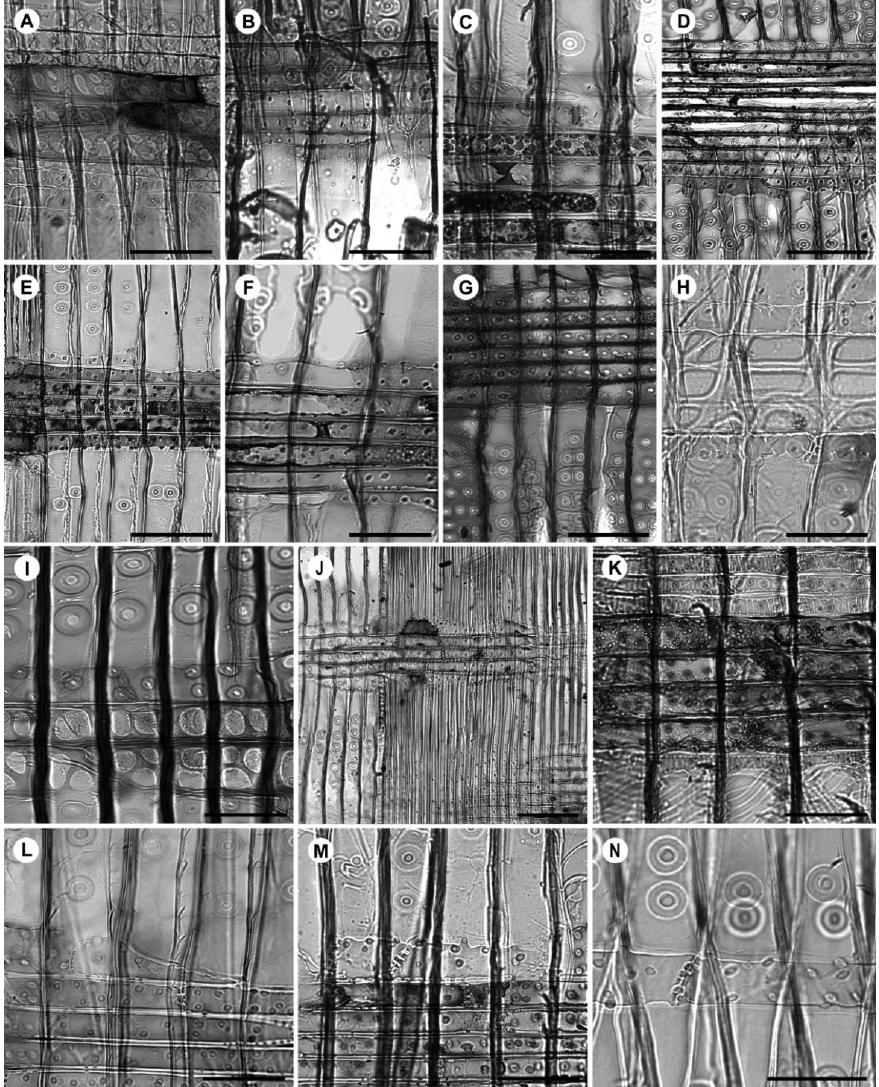
Figure 2. Rays. ( A – I ) Ray tracheids. ( A ) Pinus echinata . ( B ) Picea alcoquiana . ( C ) Larix occidentalis . ( D ) Cedrus atlantica . ( E ) Nothotsuga longibracteata . ( F ) Tsuga diversifolia . ( G ) Ray tracheids absent Keteleeria davidiana . ( H ) Dentate ray tracheids Pinus resinosa . ( I ) Smooth ray tracheids Pinus wallichiana var. wallichiana . ( J ) Irregularly shaped marginal ray cells Cedrus libani . ( K ) Helical thickenings in ray tra- cheids Pseudotsuga sinensis . ( L – N ) Ray parenchyma. ( L ) Pitted horizontal walls Abies nephrolepis . ( M ) Nodular end walls Abies nordmanniana subsp. equi-trojani . ( N ) Indenture Abies vejari . Scale bars: in ( A – C , F , H , I , K – N ) = 50 μ m, in ( D , E , G ) = 100 μ m, in ( J ) = 150 μ m. Three types of ray tracheids have been differentiated in Pinus: smooth ( P. armandii,